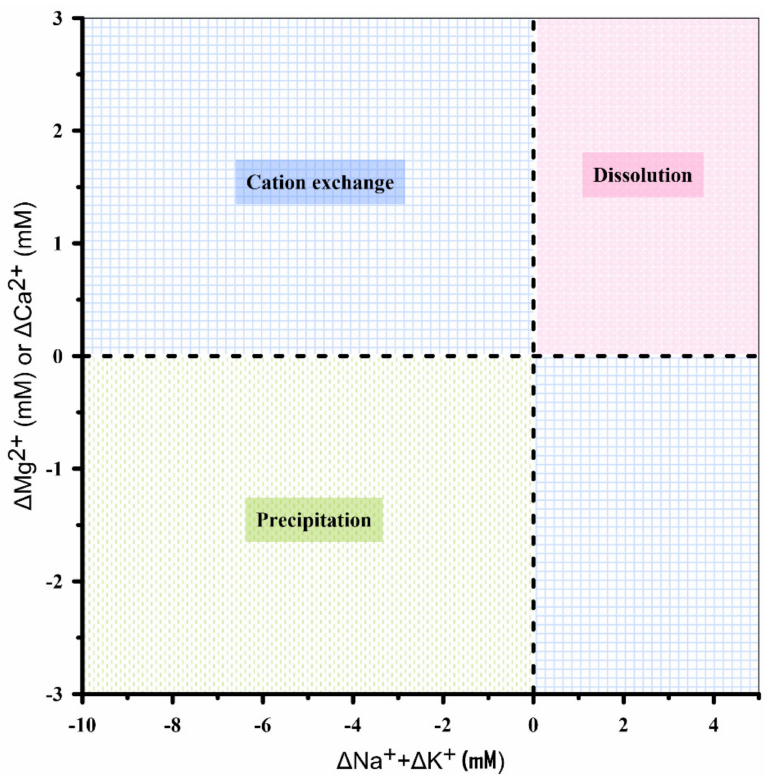
Figure 4. Plot of ∆ Mg 2+ or ∆ Ca 2+ vs. ∆ Na + + ∆ K + , showing the mechanism by which major cations participate in coastal groundwater